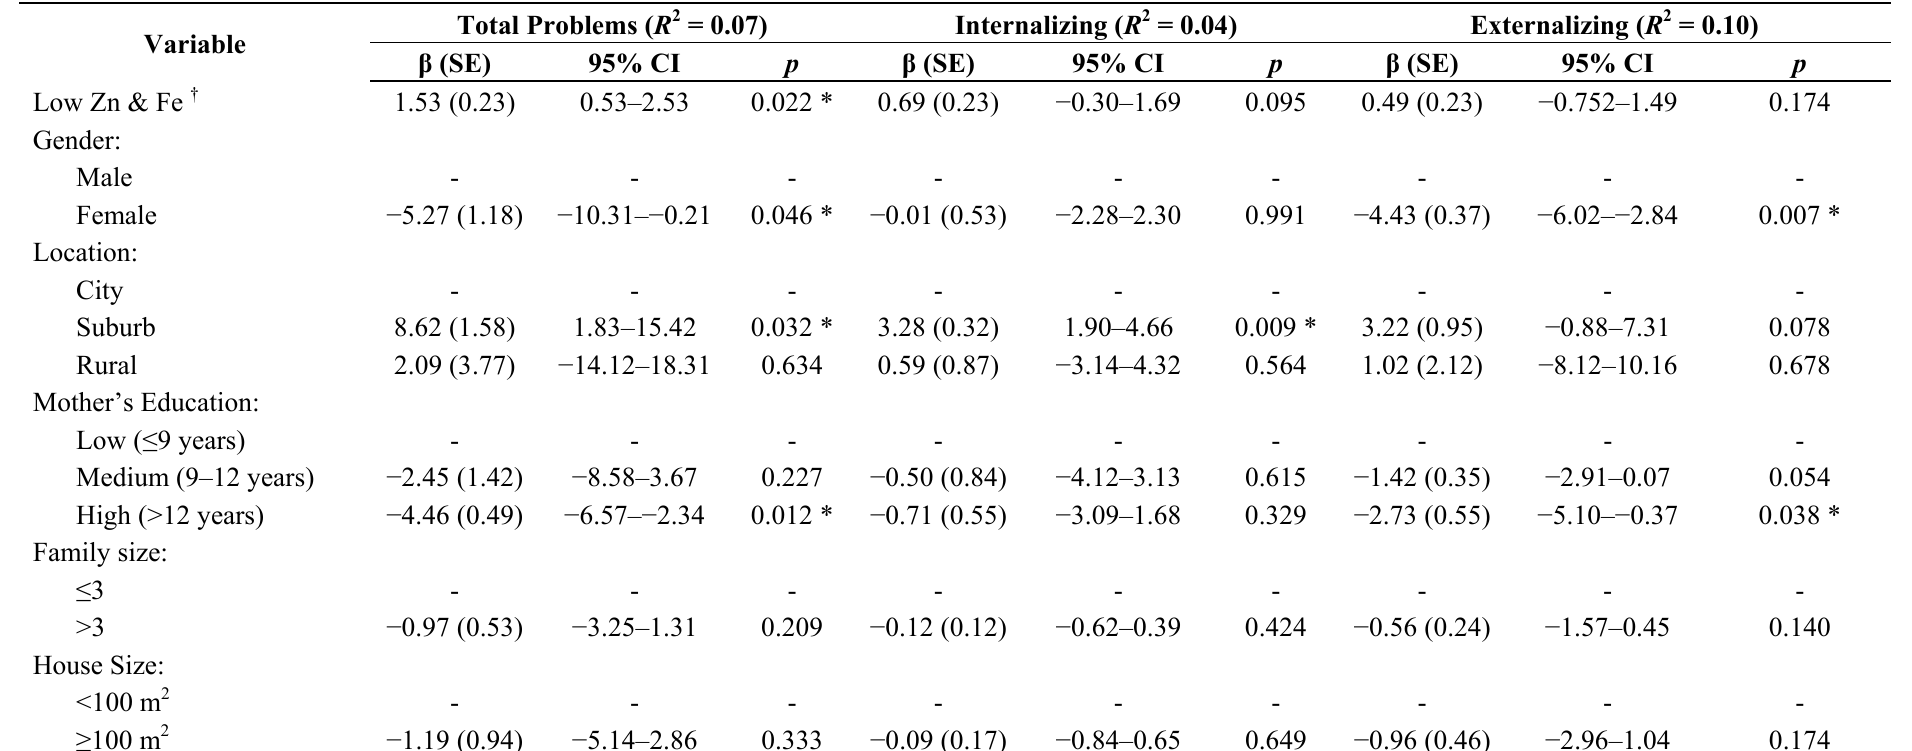
Table 7. The effect of Zinc and Iron on children’s behavior problems ( N =